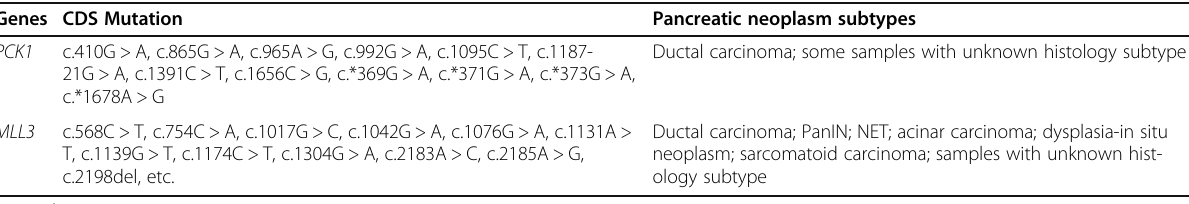
Table 2 Somatic mutations of PCK1 and MLL3 in pancreatic neoplasms in COSMIC database Genes CDS Mutation Pancreatic neoplasm